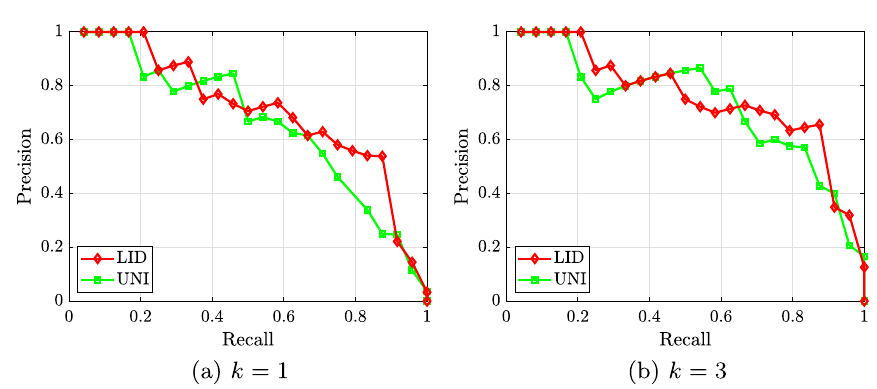
Fig. 3 Examples of precision–recall